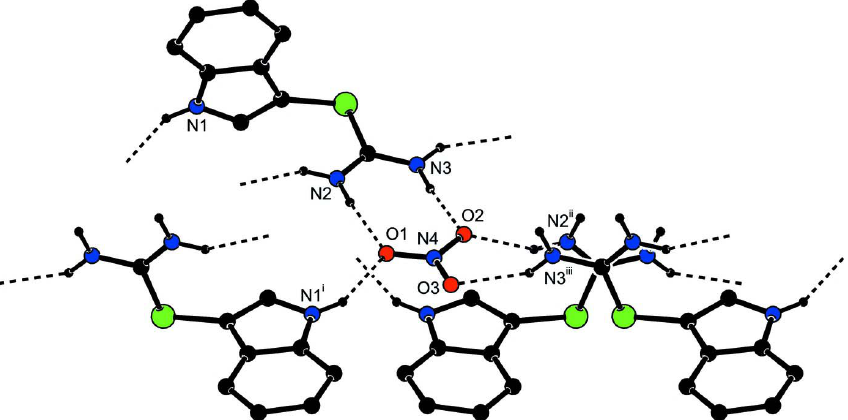
Figure 2 Hydrogen bonding scheme in compound (I). View along the crystallographic b axis. C—H hydrogen atoms are omitted for clarity. Symmetry operations i: 1 - x , 1/2 + y , 0.5 - z ; ii: 1/2 + x , y , 0.5 - z ; iii: 2 - x , 1/2 + y , 0.5 - z .